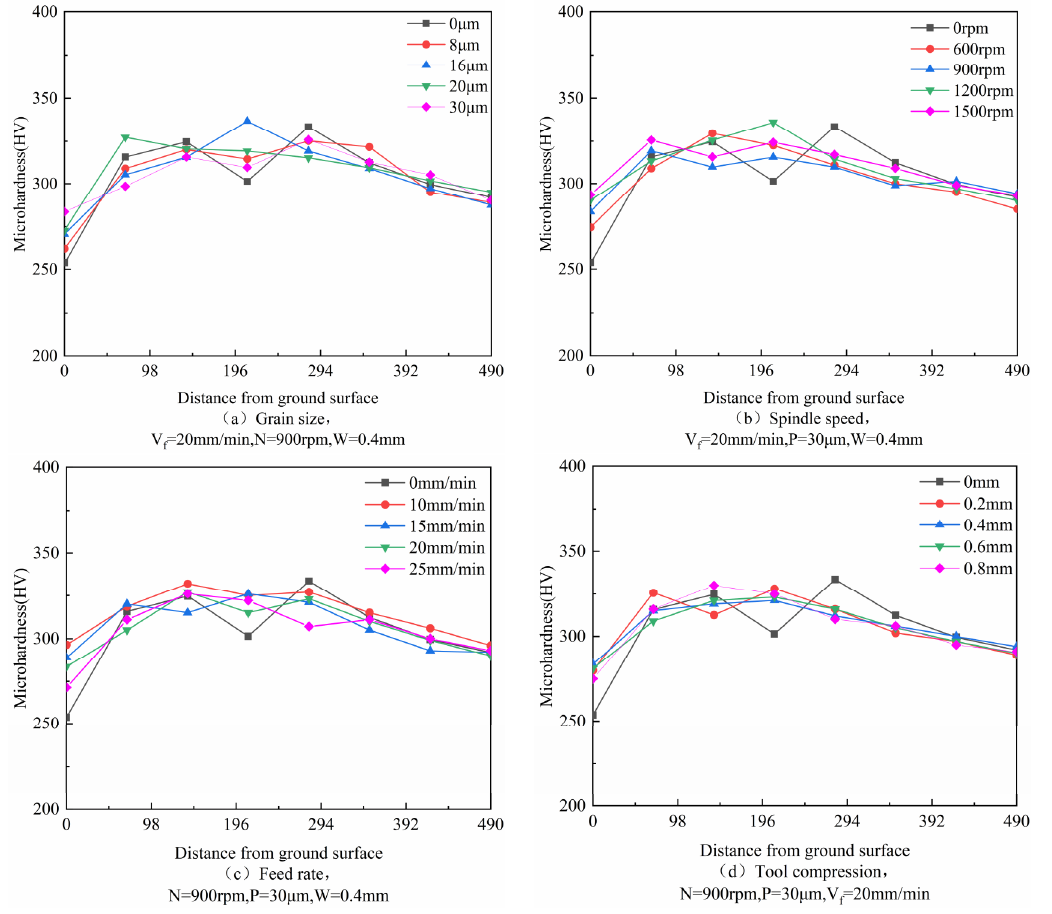
Figure 12. Microhardness depth distribution of sample surface under different grinding conditions: ( a ) Grain size, ( b ) Spindle speed, ( c ) Feed rate, ( d ) Tool compression.